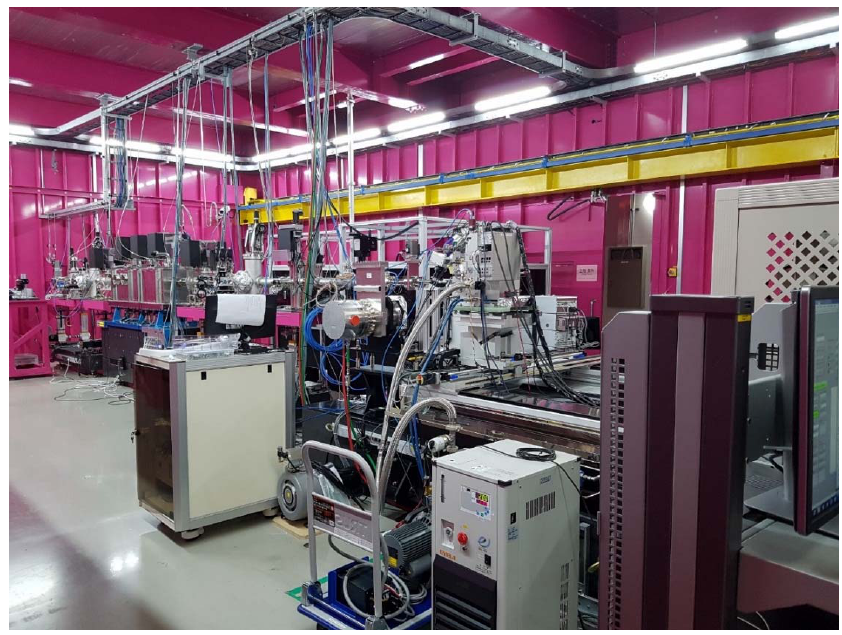
Figure 7. Inside view of HEH2.